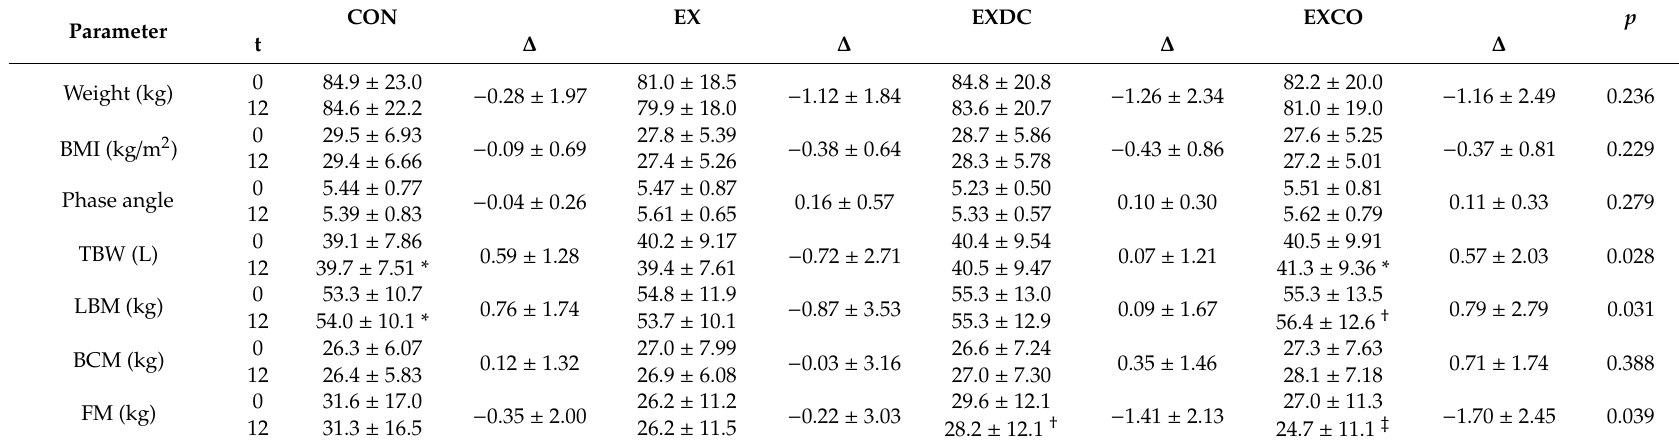
Table 4. Body composition and absolute changes ( ∆ ) of the four groups at the beginning (0) and at the end (12) of the study of all four study groups. CON EX EXDC Parameter